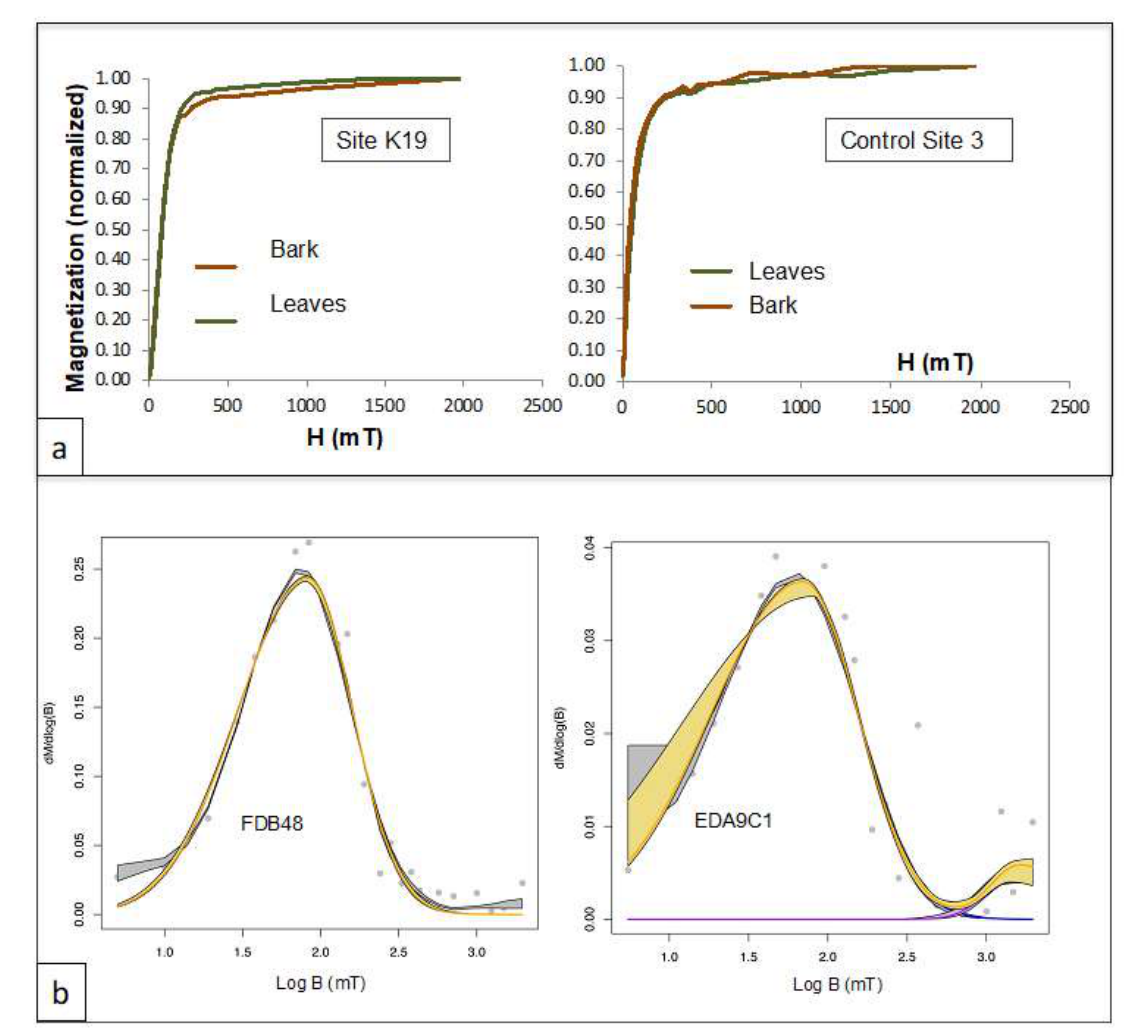
Figure 6. Isothermal Remanent Magnetization. ( a ) IRM acquisition curves for samples from site K19 and the control site 3 taken during campaign C (mid-November). Curves do not saturate for fields up to 2T, indicating the presence of high coercivity minerals (goethite and/or hematite). At site K19, bark displays a higher contribution to the IRM of high coercivity minerals. ( b ) IRMs showing a high coercivity component in the side streets highlighted by the analysis of IRM components using the MaxUnmix program [34]. Shown in gray are the data, black is the spline, yellow is the fitting model, and pink and purple are components 1 and 2, respectively. Shaded areas of each color represent error envelopes of 95% confidence